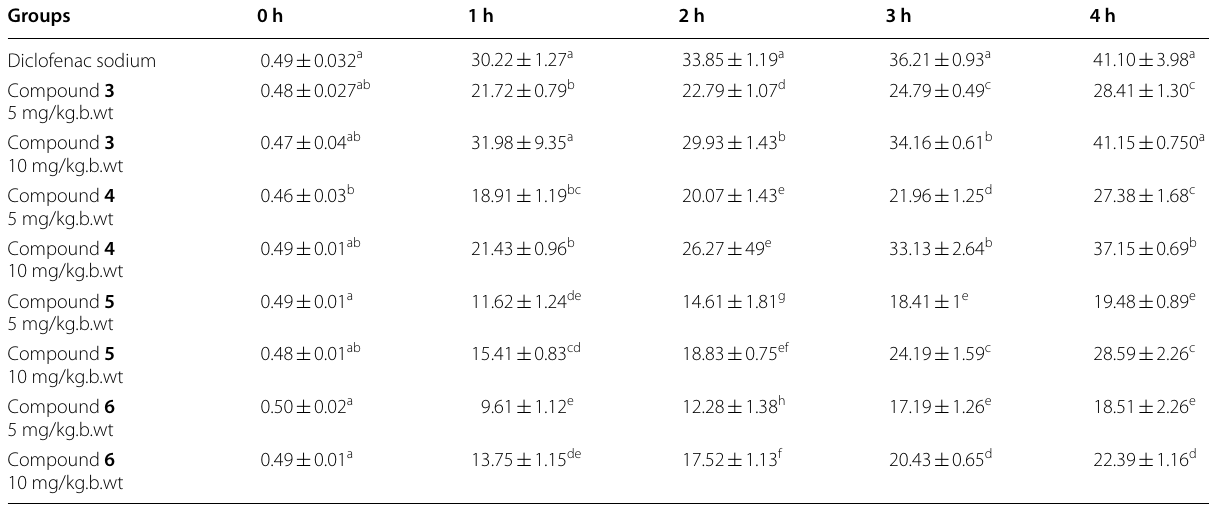
Values are expressed as mean Different superscript letters are significantly different at P